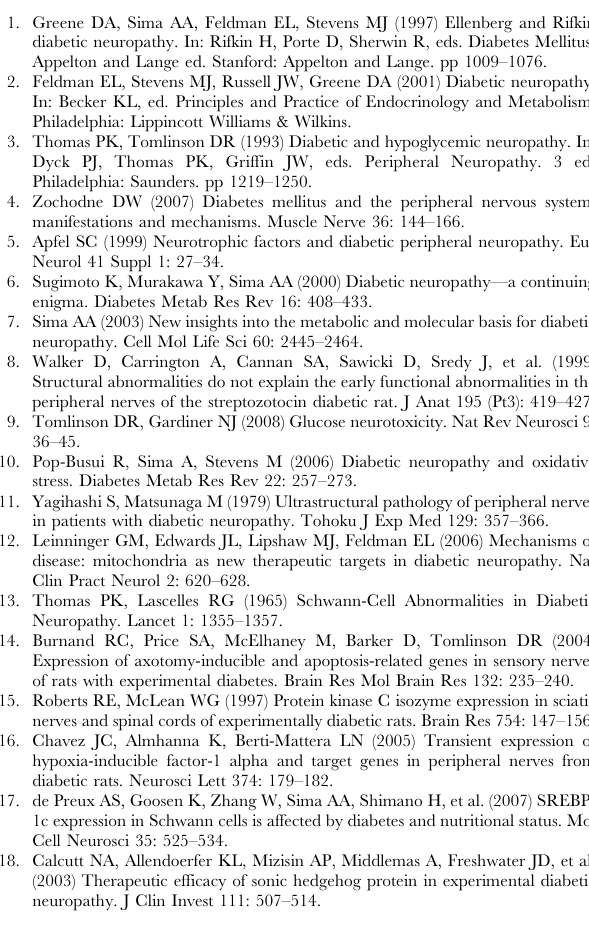
Figure S3 Schematic description of the microarray filtering criteria. Data are represented as a fold change between diabetic